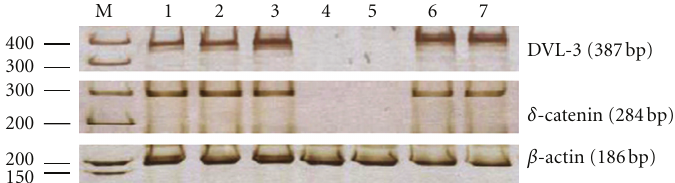
Figure 1: RT-PCR amplified products of DVL-3, δ -catenin, and β -actin in pleural e ff usions of patients with lung cancer and benign diseases. The 387, 284, and 186 bp DNA fragments were expected to be amplified from DVL-3, δ -catenin, and β -actin cDNAs, respectively. Lane M represented DNA marker (50–500 bp). Lanes 1, 2, 3, 6 and 7 represented pleural e ff usion of patients with lung cancer, respectively. Lanes 4 and 5 represented pleural e ff usion of patients with benign diseases, respectively.